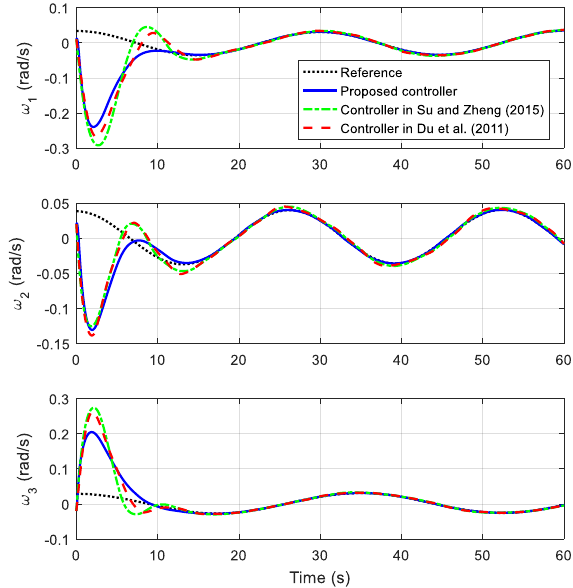
Figure 3. Profile of the angular velocity tracking ω [18,21].